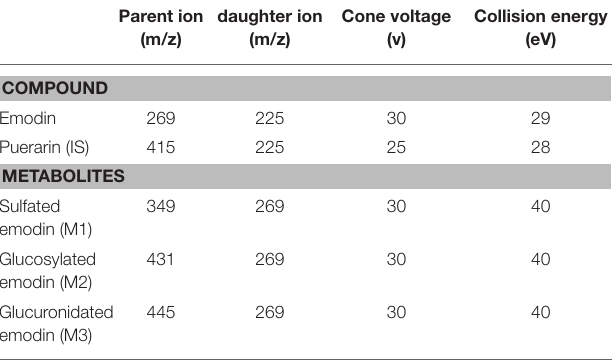
TABLE 1 | MS/MS parameters for detection of analytes and IS. Parent ion daughter ion Cone voltage Collision energy (m/z) (m/z) (v)